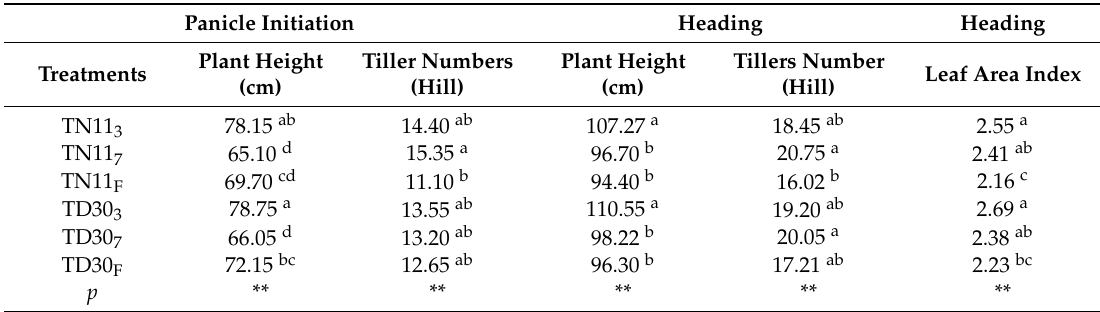
Table 2. Effect of irrigation regimes on plant height, tiller numbers and leaf area. Panicle Initiation